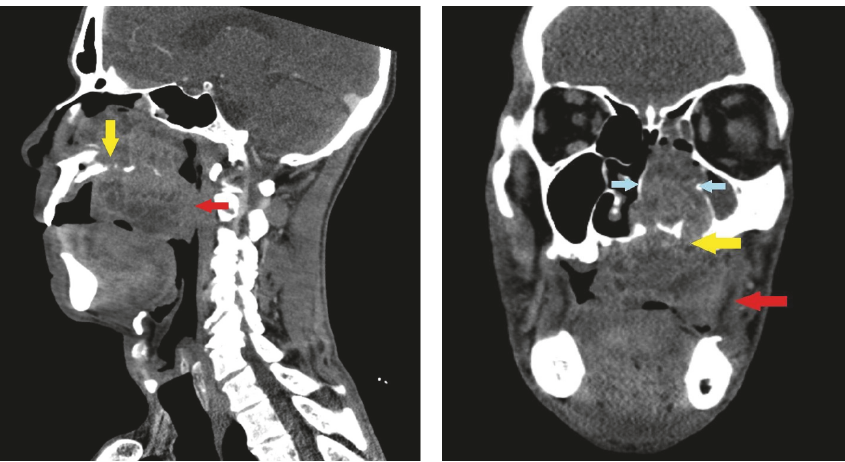
Figure 1: Sagittal and coronal contrast-enhancedCT images of the neck show a large, heterogeneously enhancing and locally aggressive mass centered at the hard palate to the left of midline. Mass erodes the hard palate (yellow arrow) and extends superiorly into the nasal cavity with extensive bony remodeling (blue arrows). Large exophytic component projects into the oral cavity (red arrow).